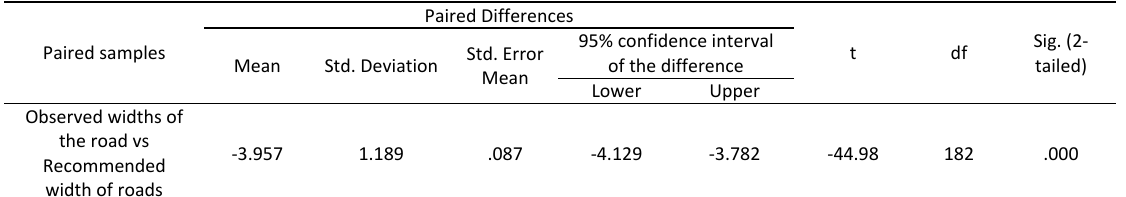
Table 10: Test for significance on minimum road reserve